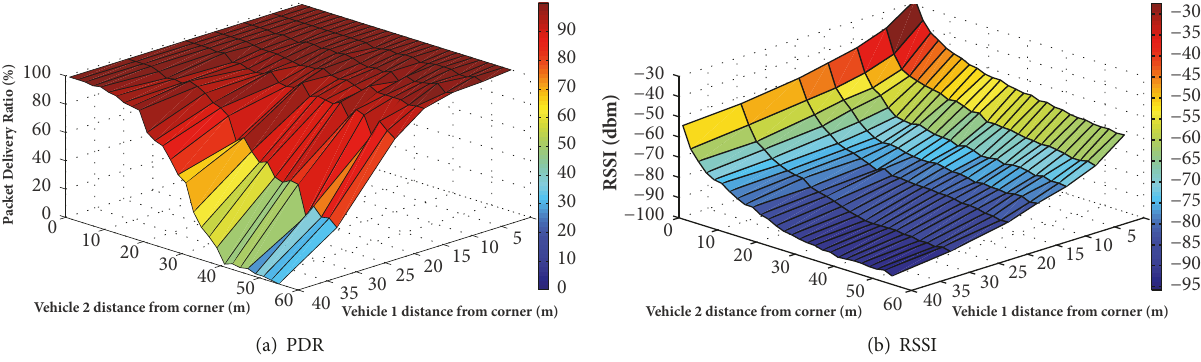
Figure 17: Results from the simulation with 𝛼 = 0.5 for blind corner with small obstruction. (a) PDR. (b) RSSI.